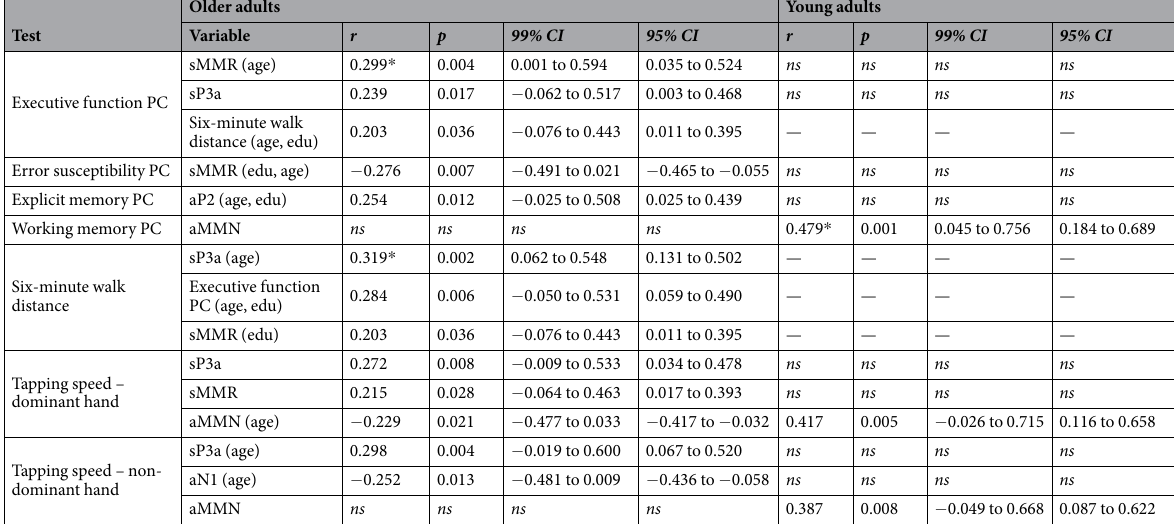
the function of the somatosensory cortex. For sP3a, no group differences were found, and the deviant vs. standard differential response was significant in both groups. The pattern of results in the somatosensory modality show-